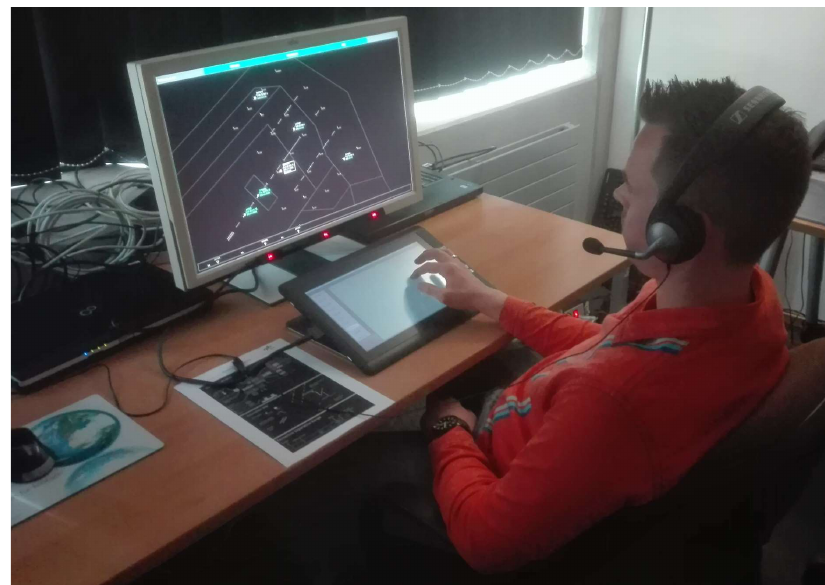
Figure 5. Participant during TriControl trials before command confirmation and after uttering a value, performing a multi-touch gesture. His gaze is being recognized at an aircraft almost on final (white radar label box).